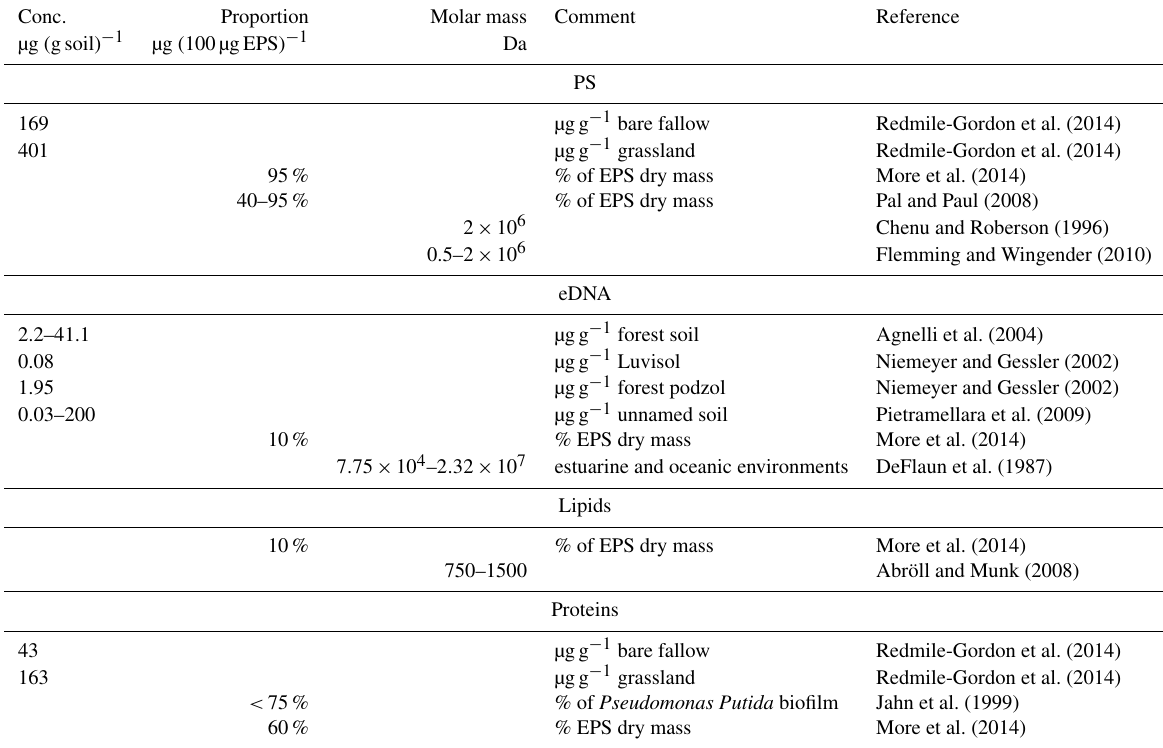
Table 1. Concentrations and molar masses of biofilm stabilizing macromolecules (polysaccharides – PS, eDNA, lipids and proteins) in different environments.